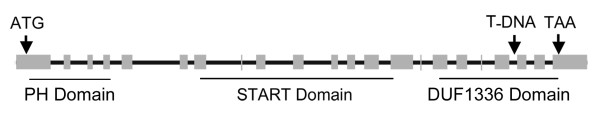
Predicted EDR2 gene and protein structure. Intron-exon structure of the EDR2 gene. The regions of the gene corresponding to the PH, START and DUF1336 domains are indicated by lines and the site of the T-DNA insertion in the edr2-6 mutation is indicated by an arrow along with the ATG start codon and TAA stop codon.